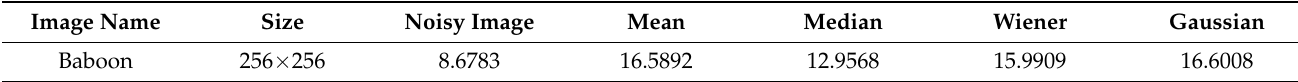
Table 3. Baboon image under four classical filtering algorithms for PSNR (dB).